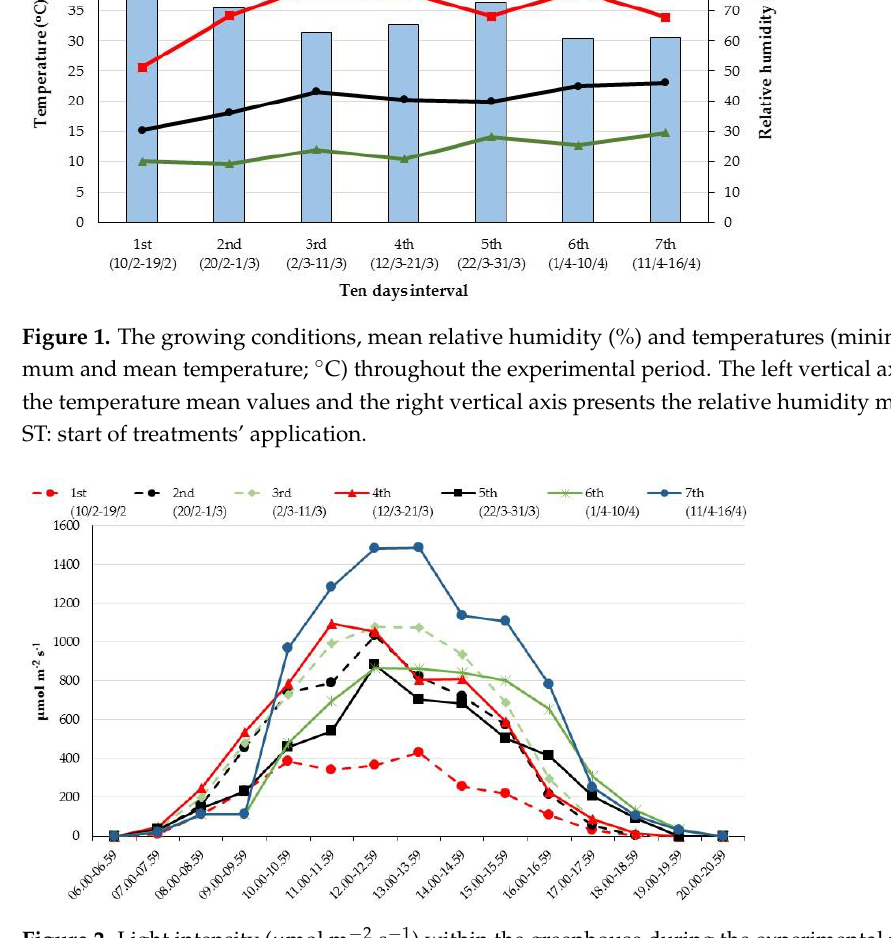
Figure 2. Light intensity ( µ mol m − 2 s − 1 ) within the greenhouse during the experimental period. The values are the means of 10 days’ intervals for hourly recordings.